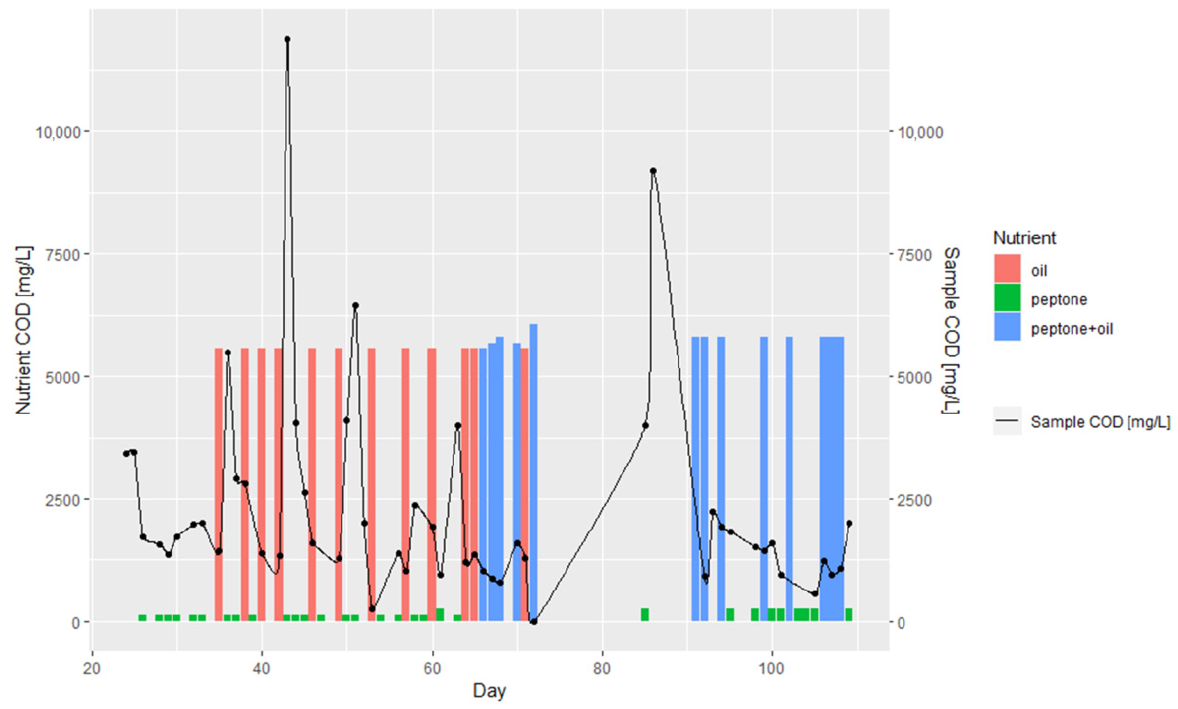
Figure 5. Relationship in time between chemical oxygen demand, nutrient medium, and unfiltered sample from the batch bioreactor.